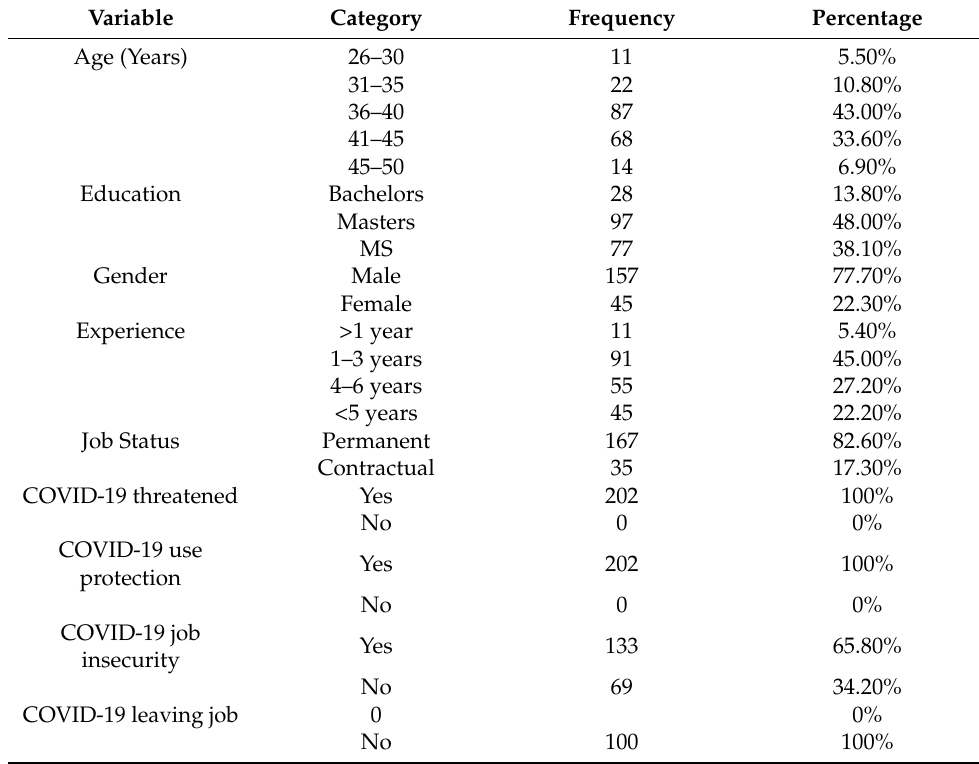
Table 1. Demographics and COVID-19 Questions, n =